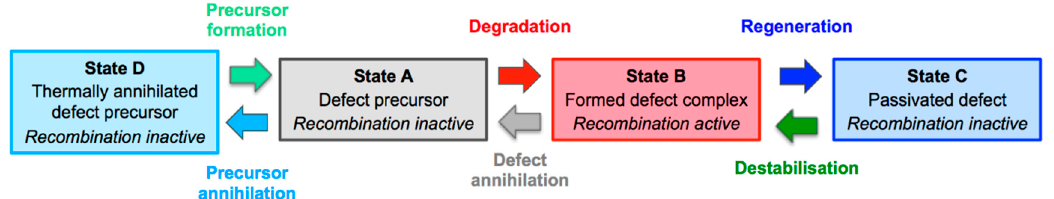
Figure 1. Simplified diagrammatic representation of the boron-oxygen (B-O) defect system.